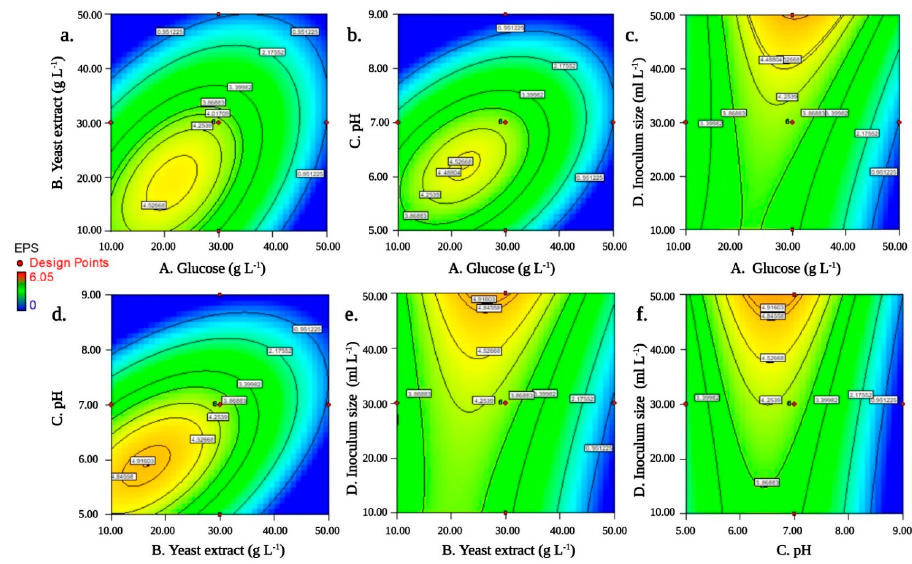
Figure 3. Response surface plot (2-D) interaction effect expressed, respectively, in X1 and X2 axes. Here, inputs are 30 experimental runs carried out under conditions established by CCD matrix. EPS production as function with ( a ) Glucose (g L − 1 ) and yeast extract (g L − 1 ) (Actual factors C. pH = 7.00, D. Inoculum size = 30.00 mL L − 1 ); ( b ) Glucose (g L − 1 ) and pH (B. Yeast extract = 30.00 g L − 1 , D. Inoculum size = 30.00 mL L − 1 ); ( c ) Glucose (g L − 1 ) and inoculum